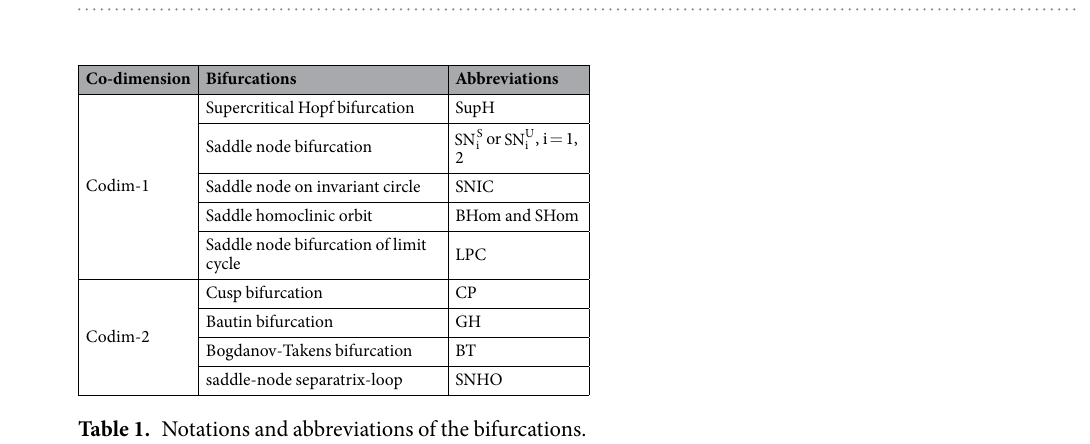
Figure 1. Effects of autaptic currents on nullcline =  V 0 . ( a ) The curves of Γ ( V ) with different Θ syn and λ . ( b ) Changes of the nullcline =  V 0 induced by the inhibitory autapse and I app = 39.96 μ A/cm 2 . ( c ) Changes of the nullcline =  V 0 induced by the excitatory autapse and I app = 52.765 μ A/cm 2 . In ( b , c ), the gray dashed curve represents nullcline of =  w 0 , the dotted curve with different colors represent nullcline =  V 0 at different autaptic strengths.